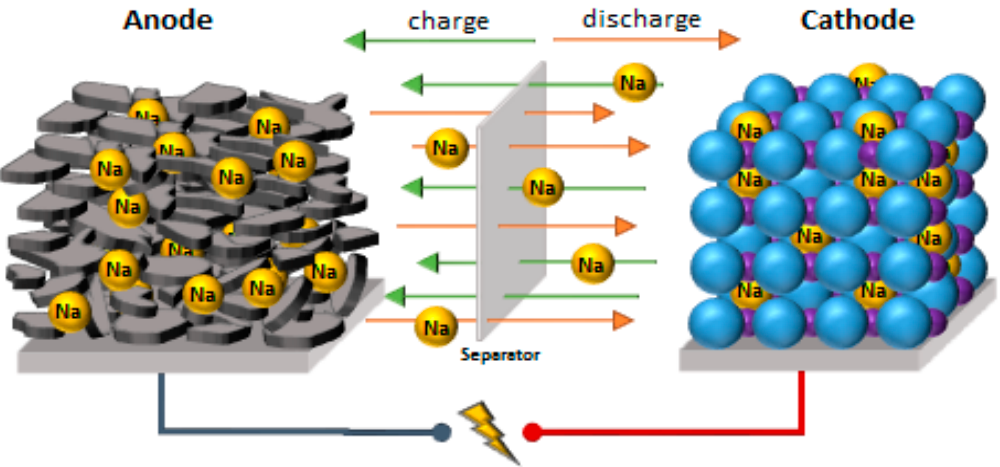
Figure 1. Working principle of the sodium-ion cell [16].